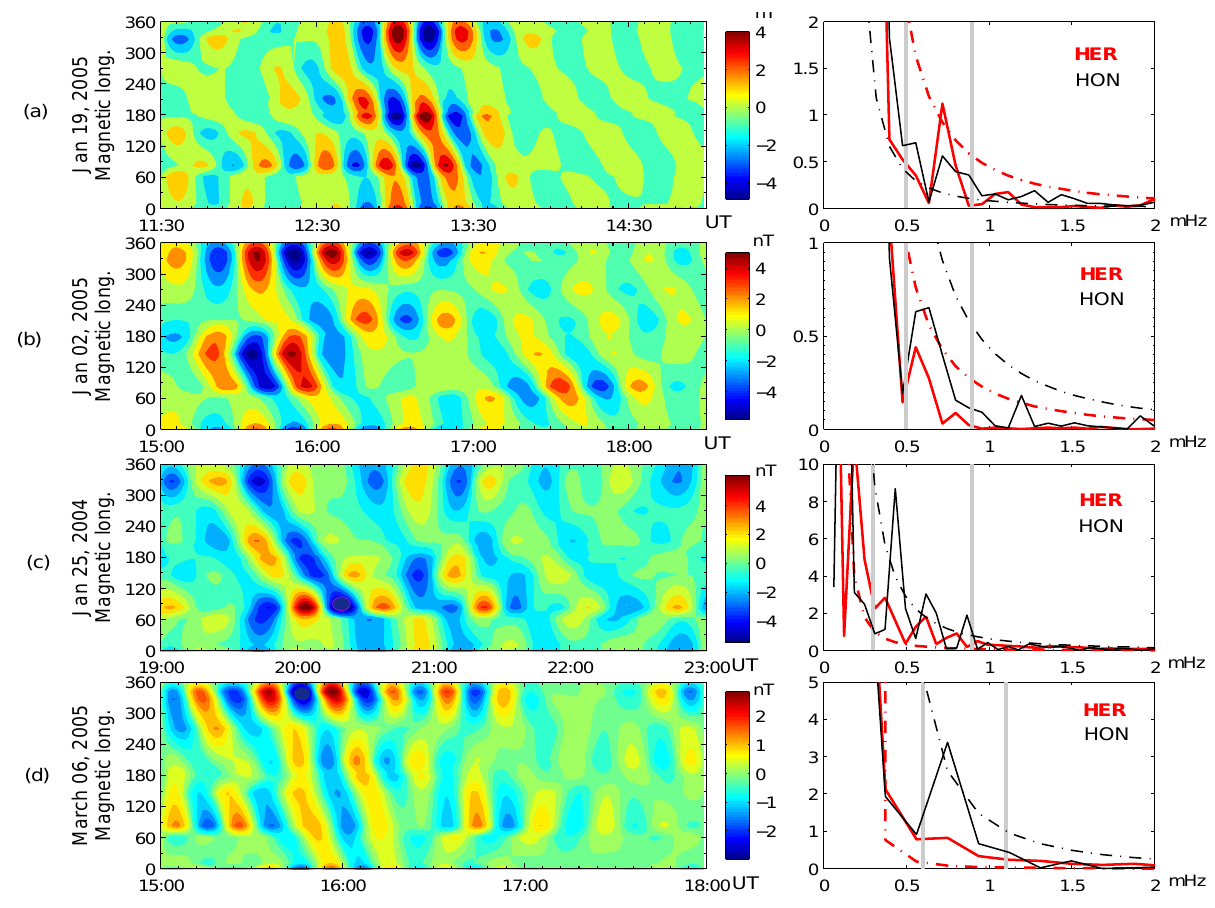
Fig. 5. Contour plot of longitudinal propagation of 1H asym and PSD of 1H at two representative stations HER and HON separated by ∼ 180 ◦ longitude on (a) 19 January 2005 in frequency range 0.5–0.9mHz, (b) 2 January 2005 in frequency range 0.5–0.9mHz, (c) 25